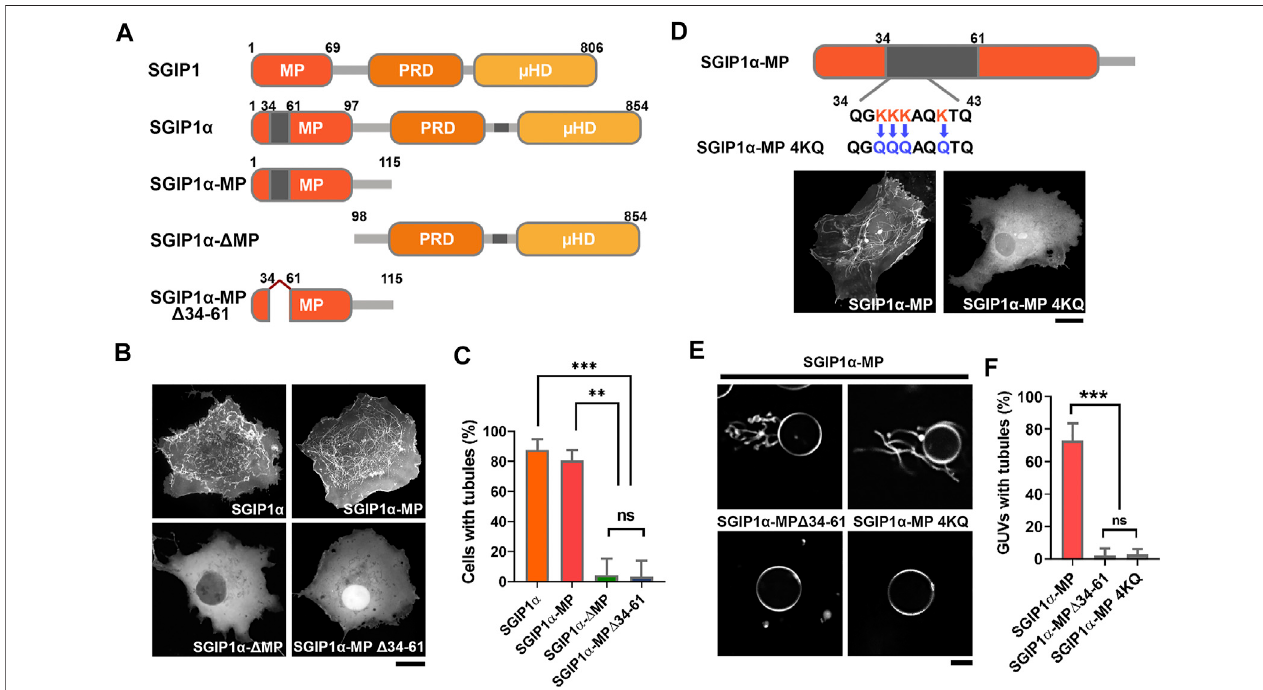
FIGURE 2 | The additional 28 amino acids in the MP domain of SGIP1 α are essential for membrane tubulation. (A) Schematic diagram of the domain structure of SGIP1, SGIP1 α , SGIP1 α -MP, SGIP1 α - Δ MP and SGIP1 α -MP Δ 34-61 used in this study. (B) Representative images of EGFP-tagged SGIP1 α , SGIP1 α -MP, SGIP1 α - Δ MP,andSGIP1 α -MP Δ 34-61inCOS7cells.Scalebar:10 μ m. (C) Cellswithtubules(%)ofeachSGIP1construct.One-wayANOVAfollowedbyTukey ’ sHSDtest. n (cid:1) 3 (50cellsperconstructforeachindependentexperiment).(D)SchematicdiagramofSGIP1 α MP4KQconstructandrepresentativeimagesofEGFP-taggedSGIP1 α MP and 4KQ in COS7 cells. Scale bar: 10 μ m. (E) GUV tubulation assay in vitro . Representative images of POPC/DOPE/DOPS/DOGS-NTA Ni/DiI GUV of puri fi ed His- tagged SGIP1 α -MP, SGIP1 α -MP Δ 34-61, and SGIP1 α -MP 4KQ. Scale bar: 10 μ m. (F) GUV with tubules (%) of each SGIP1 construct. n (cid:1) 3 (50 cells per construct for each independent experiment). * p < 0.05; ** p < 0.01; *** p < 0.001. Error bars indicate mean ± s.e.m.